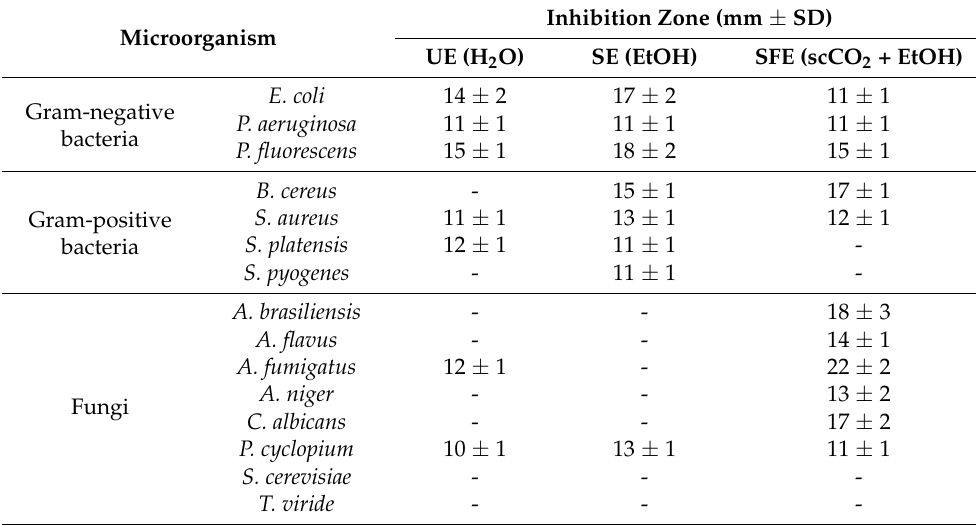
Table 4. Qualitatively determined antibacterial activity of AS extracts obtained by ultrasonic extraction (UE), Soxhlet extraction (SE), and supercritical fluid extraction (SFE) on selected bacteria and fungi. Inhibition Zone (mm ± SD) Microorganism UE (H 2 O) SE (EtOH) SFE (scCO 2 + EtOH) E. coli 14 ± 2 17 ± Gram-negative bacteria